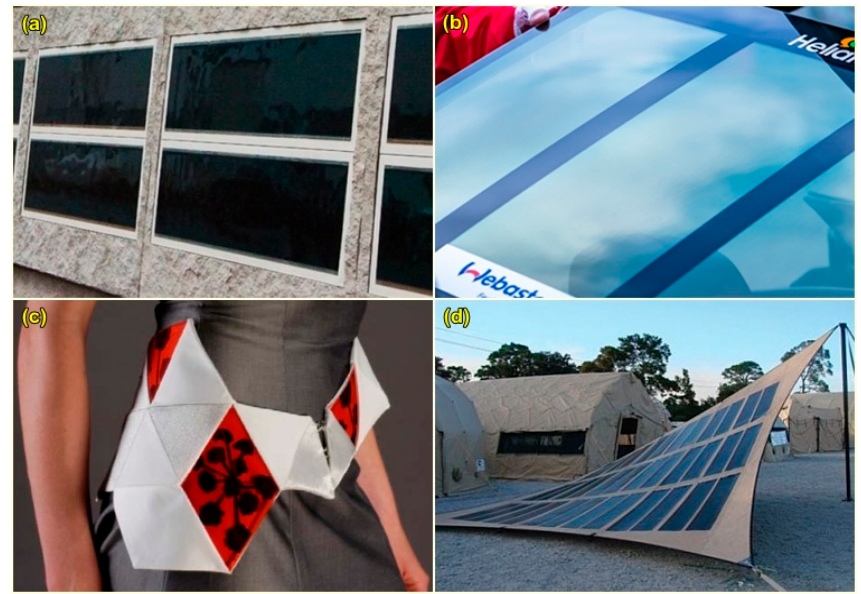
Figure 11. Applications of polymer solar cells; ( a ) integration on concrete façade [218]; ( b ) integration on car rooftop [218]; ( c ) integration on clothing [222]; and ( d ) integration on military tent [223]. Table 3. Building integration of Organic polymer solar cells by Heliatek. Adapted from